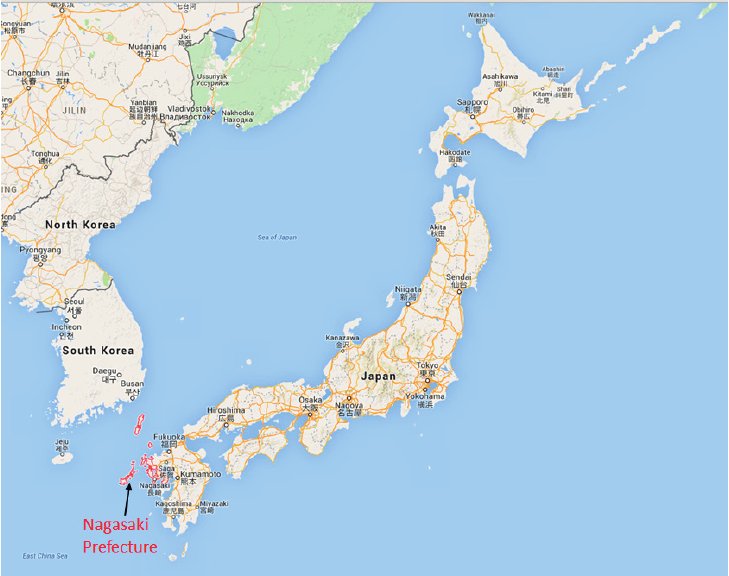
Figure 1. Location of Nagasaki Prefecture in Japan.